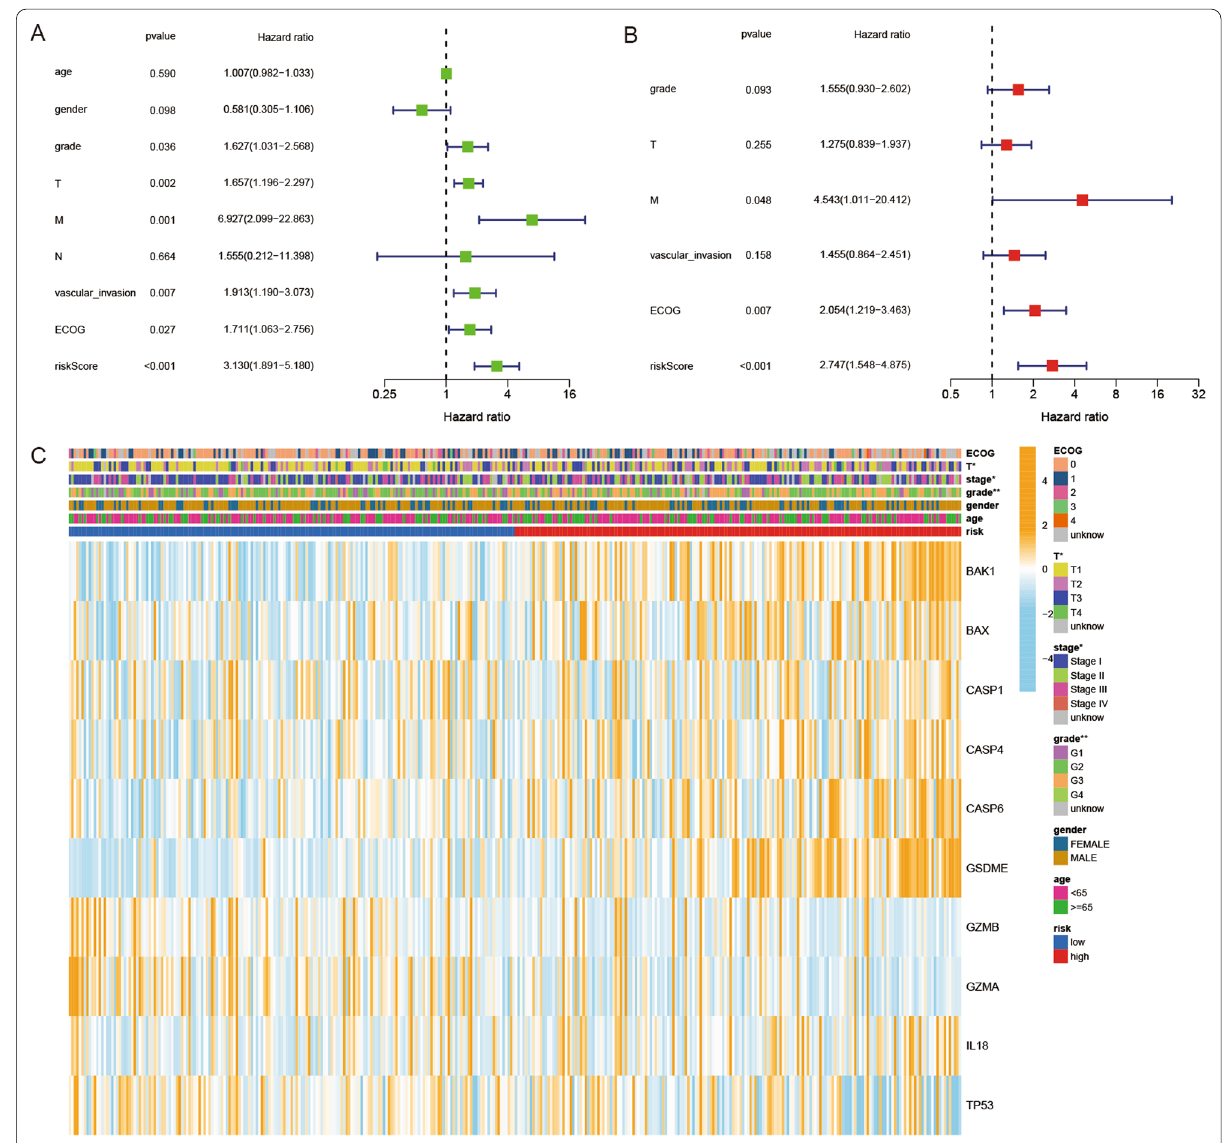
Fig. 5 Univariate and multivariate Cox regression analyses for the risk score. A Univariate analysis for the TCGA cohort. B Multivariate analysis for the TCGA cohort. C Heatmap (blue: low expression; orange: high expression) for the connections between clinicopathologic characteristics and the risk groups (*p < 0.05, **p <